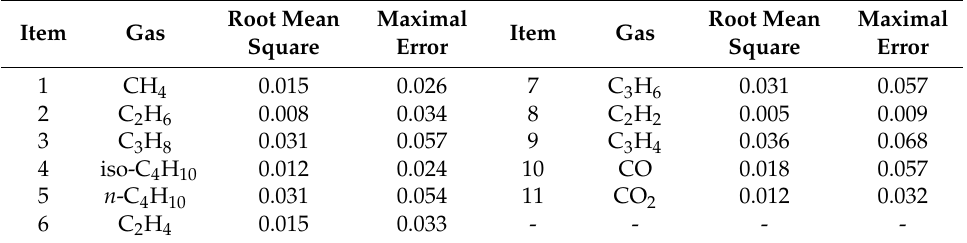
Table 2. Root mean square of the analyte and maximal analysis error in the case of background spectra (L/L).